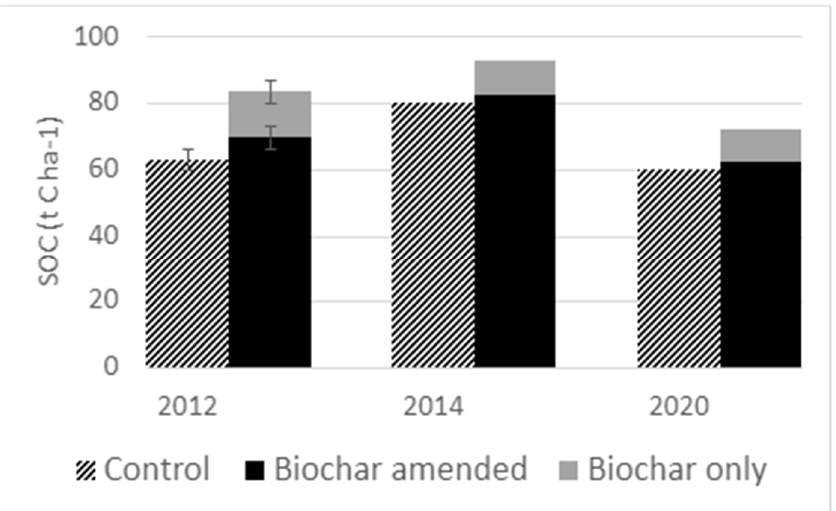
Figure 2. SOC changes in a field experiment simulation in two treatments: control and biochar amended. This figure shows the results of the simulation for a calibrated and validated model that can discriminate between biochar and native SOC degradation (based on data from Pulcher et al. (2022) [10]).